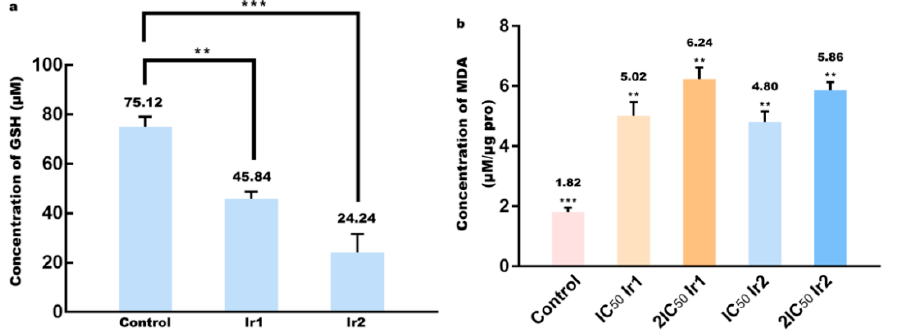
Figure 9. ( a ) Intracellular GSH and ( b ) MDA content assay after a 24 h exposure of HCT116 cells to IC 50 or 2IC 50 concentration of the complexes for 24 h. ** p < 0.01, *** p < 0.001.